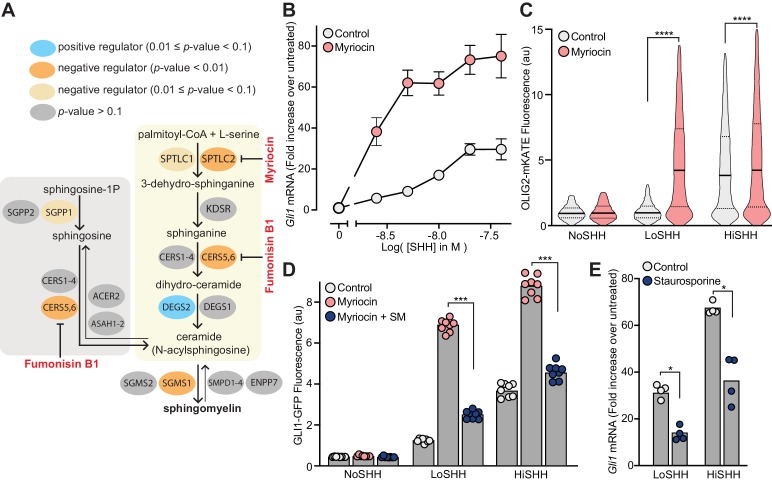
Enzymes that generate sphingomyelin negatively regulate hedgehog signaling.(A) The pathway for the synthesis of SM, with enzymes colored according to their FDR corrected p-value in our CRISPR screens. Steps in the pathway blocked by myriocin and fumonisin B1 are denoted in red. (B) A dose-response curve for SHH in myriocin-treated NIH/3T3 cells compared to control cells treated with vehicle (DMSO) alone. Error bars represent the standard error of the mean from four replicates. (C) Differentiation of spinal Neuronal Precursor Cells (NPCs) into OLIG2-positive motor neuron progenitors exposed to either LoSHH (5 nM) or HiSHH (25 nM) was assessed using flow cytometry to measure the fluorescence of a OLIG2-mKate reporter (n > 5000 cells for each treatment). (D) HH signaling strength in NIH/3T3-CG reporter cells treated with LoSHH (5 nM) or HiSHH (50 nM) after treatment with myriocin alone or myriocin followed by addition of exogenous egg SM. Each data point represents the mean GLI1-GFP fluorescence from 250 cells in two independent experiments. (E) HH signaling strength measured in NIH/3T3 cells treated with either LoSHH (5 nM) or HiSHH (25 nM) in the presence or absence of 50 nM staurosporine to increase SM. Bars denote the mean value derived from the four individual measurements shown. Statistical significance was determined by the Mann-Whitney test (C, D and E); p-values are: (C) p-value<0.0001 (both comparisons), (D) p-value=0.0002 (both comparisons), and (E) p-value=0.0286 (both comparisons).